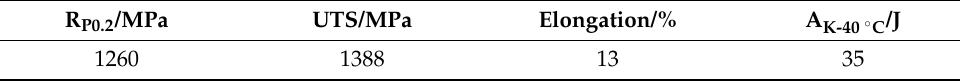
Table 2. Mechanical properties of experimental